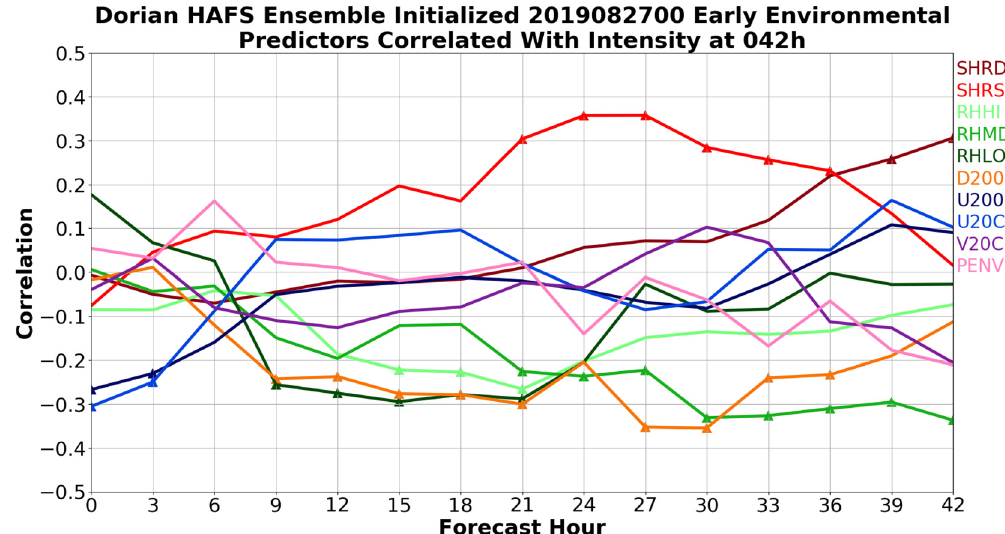
Figure 5. Correlations between all environmental predictors from 0 to 42 h with the 42 h intensity (minimum pressure) of Dorian. Positive correlation indicates that a higher value of the variable leads to a weaker storm. Forecast hours when the correlation is statistically significant ( p < 0.05) are shown with the triangles.